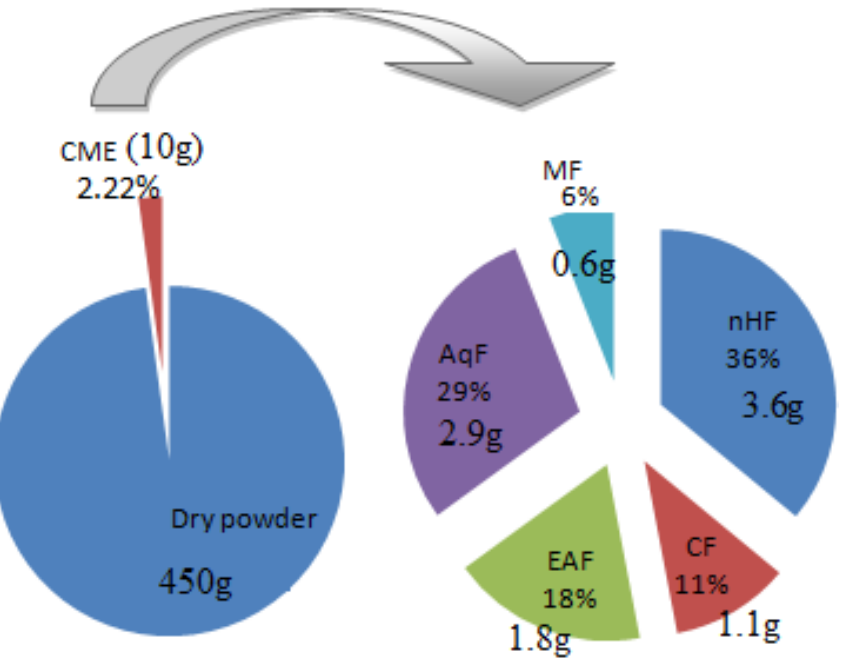
Figure 3. The percentage yield of various fractions obtained from 450 g dry weight of Dryopteris ramosa.